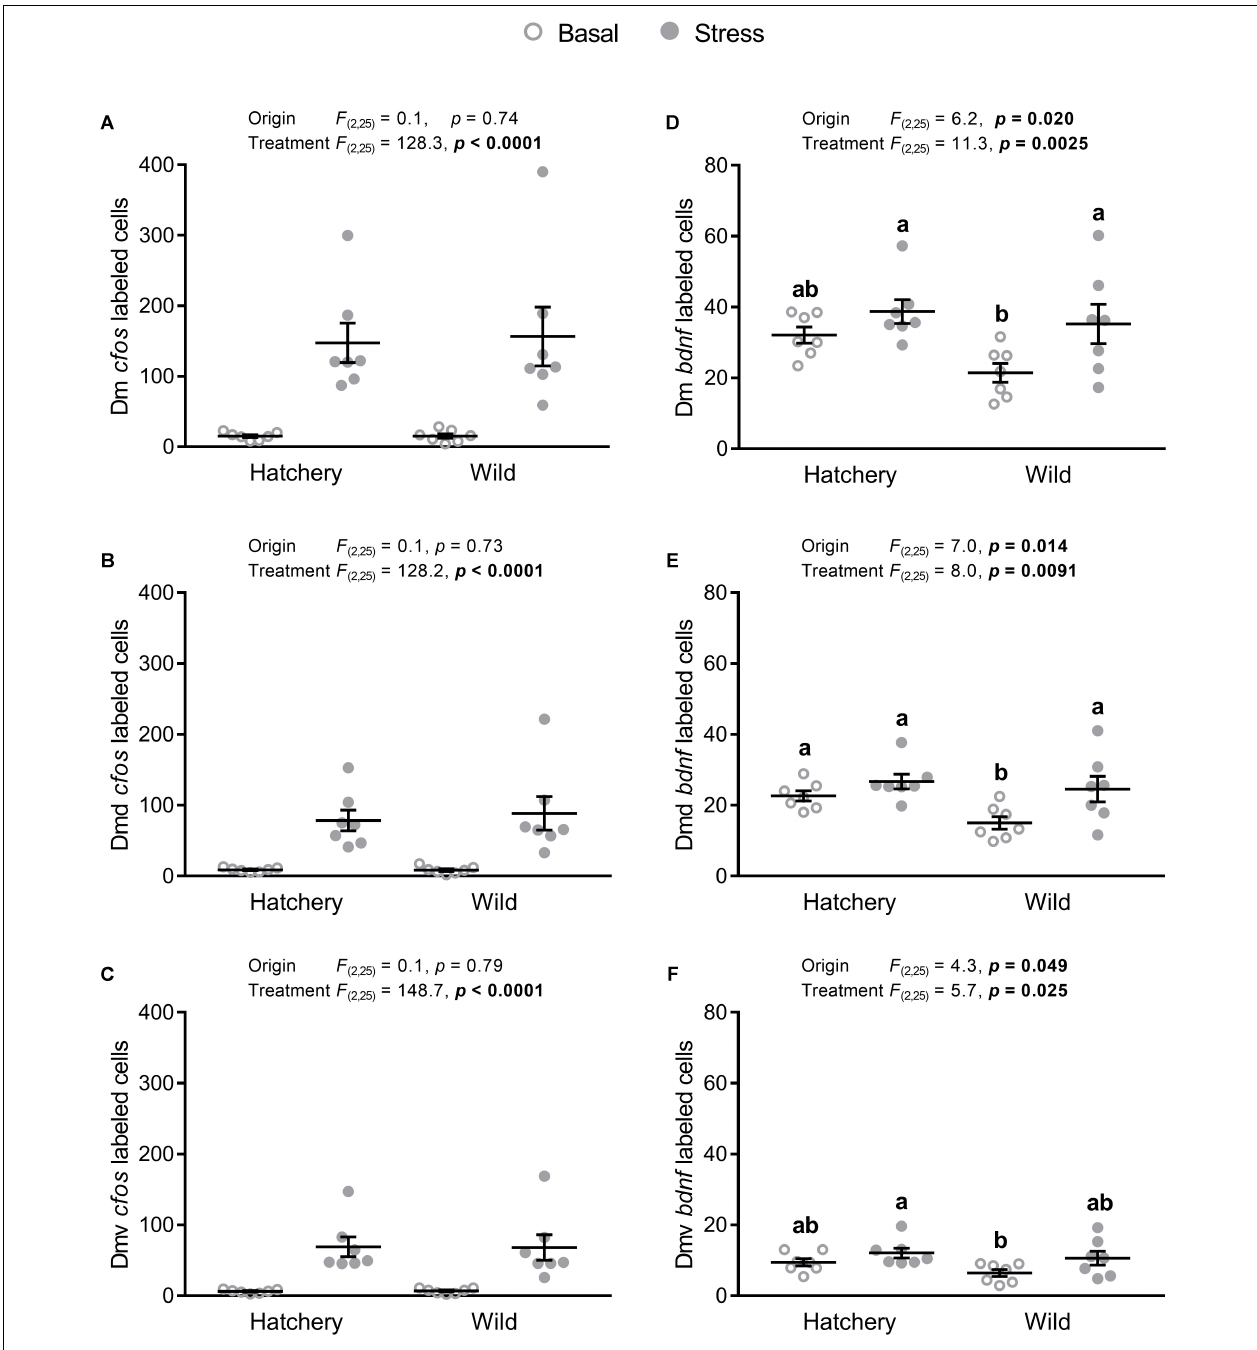
FIGURE 4 | In situ hybridization labeled cfos and bdnf cells in the Dm, Dmd, and Dmv. Effect of origin (hatchery vs. wild) and treatment (basal vs. stress) on mean ± SEM expression of cfos (A–C) and brain-derived neurotrophic factor ( bdnf ; D–F ) in the entire (dorsal + ventral) dorsomedial pallium (Dm; A , D ), as well as the dorsal only (Dmd; B , E ) and the ventral only (Dmv; C , F ) subregions. Two-way analysis of variance (ANOVA) statistics are displayed in each panel, n = 7 per treatment. Groups that do not share a similar lowercase letter are significantly different from one another (Tukey–Kramer HSD post-hoc